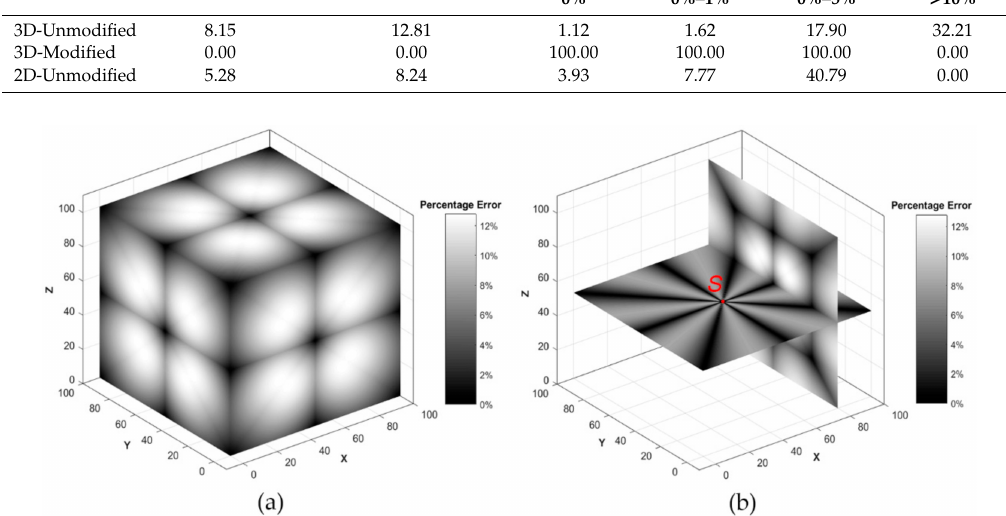
Figure 14. Percentage of distance error based on the uncorrected cost distance in a homogeneous friction space: ( a ) 3D percentage error field; ( b ) sliced error planes at X = 80 and Z = 50.